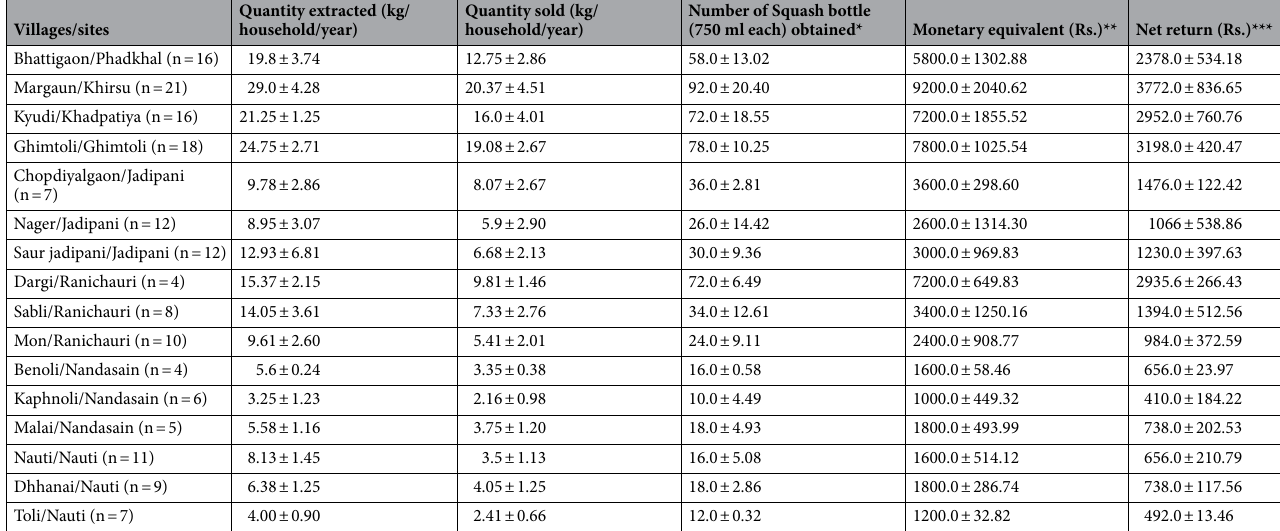
Table 4. Mean value for flower extracted, sold, preparation of squash and average income (monetary equivalent) from Rhododendron arboreum in Garhwal region. n = number of flower extractor and seller